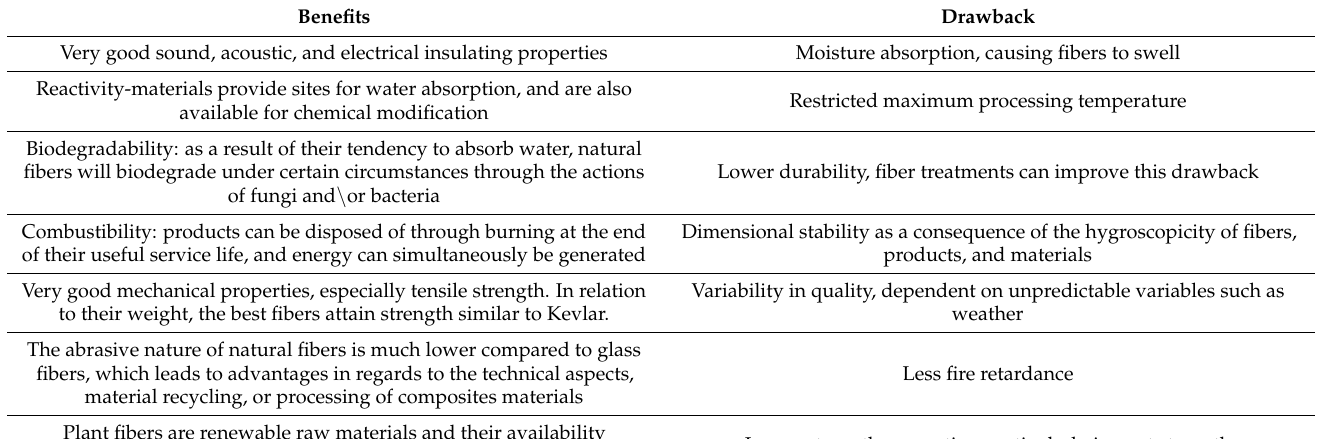
Table 1. Benefits and drawbacks of natural fiber composites